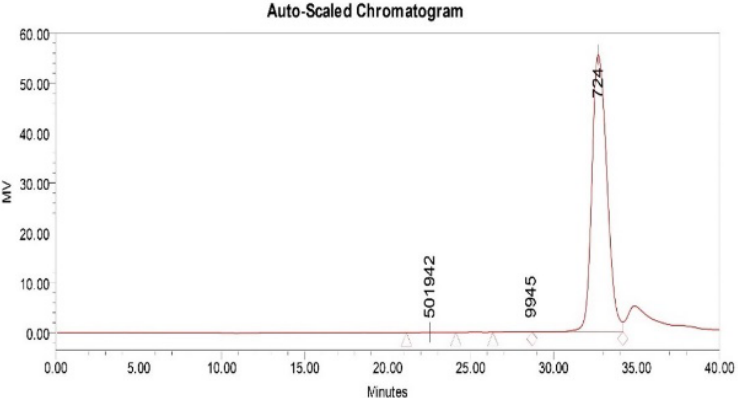
Figure 4. Size-exclusion chromatogram of Virgibacillus dokdonensis VITP14 exopolysaccharide (EPS).